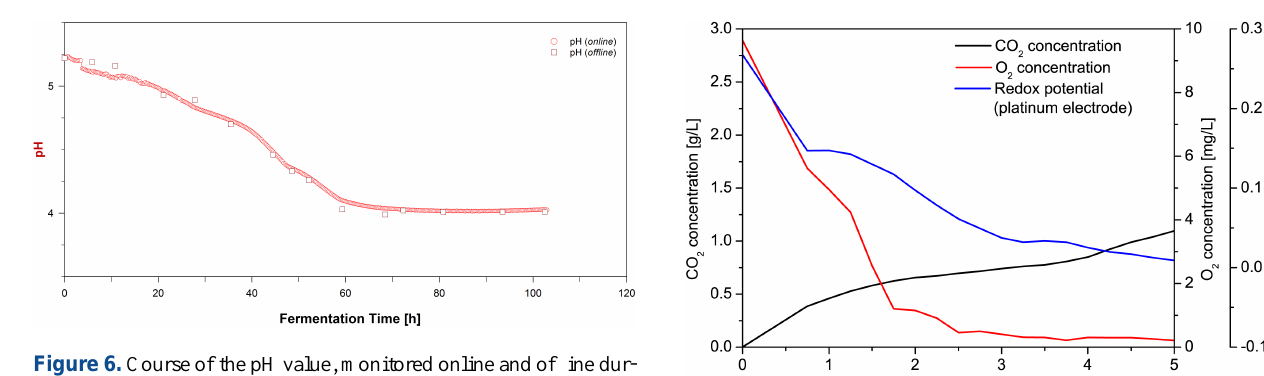
Figure 6. Course of the pH value, monitored online and offline dur- ing a fermentation process at the pilot scale (volume: 150L; 294K).